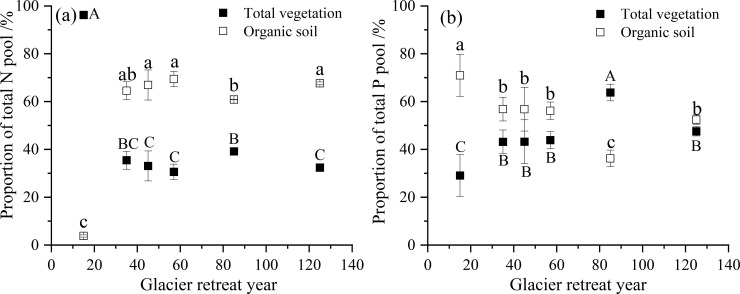
Proportion of N and P pool in vegetation and organic soil.Capital letters indicate significant differences in the proportion of N or P in total vegetation at different sites; lowercase letters indicate significant differences in the proportion of N or P in organic soil at different sites (P < 0.05).